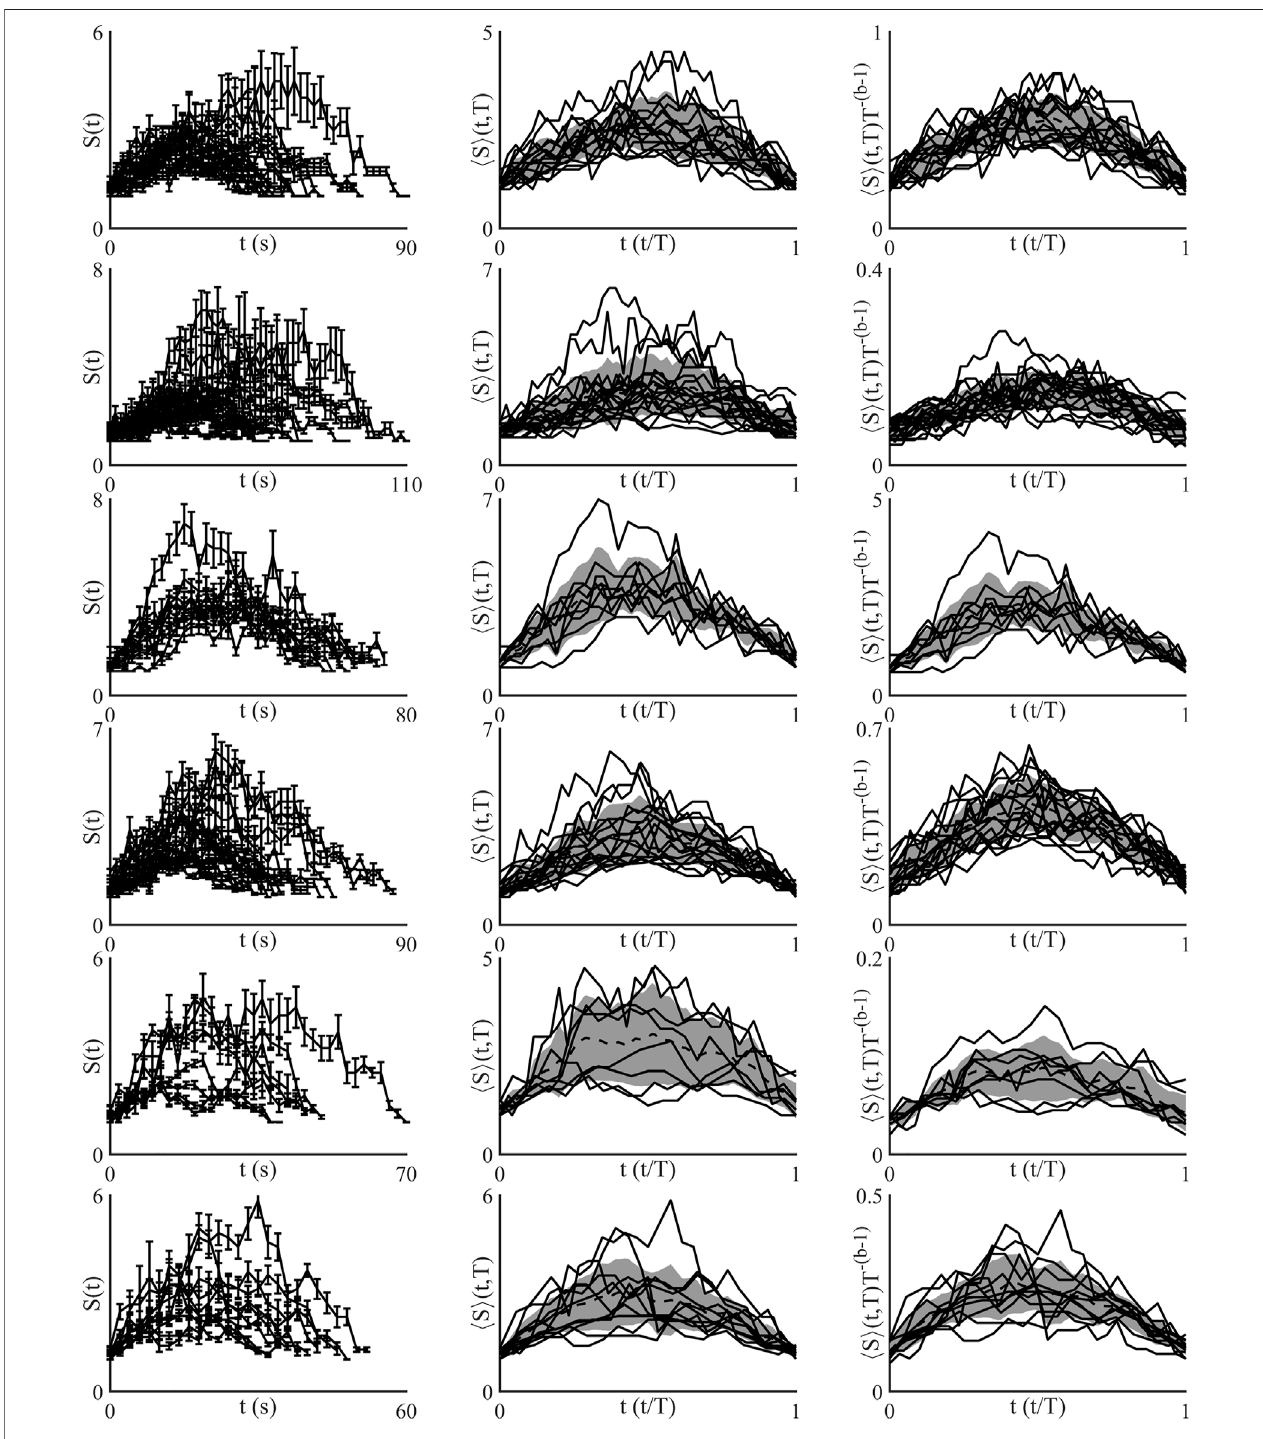
FIGURE 4 | Shape collapse of all networks analysed. The top row of images corresponds to network 1, with the subsequent rows corresponding to subsequent networks. All networks show a universal shape similar to a parabola, although the shape has a slight left skew. Network 3, third row, shows the poorest shape collapse.